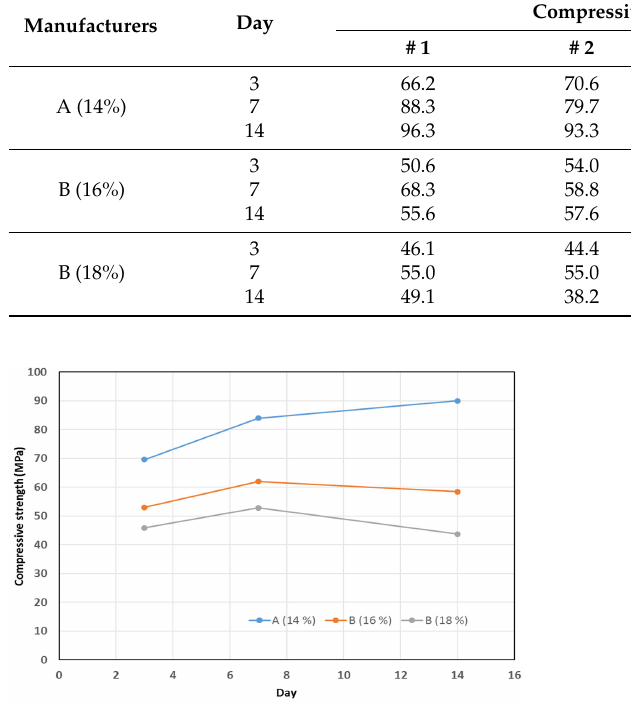
Figure 8. Compressive strength plots of the cubic mold